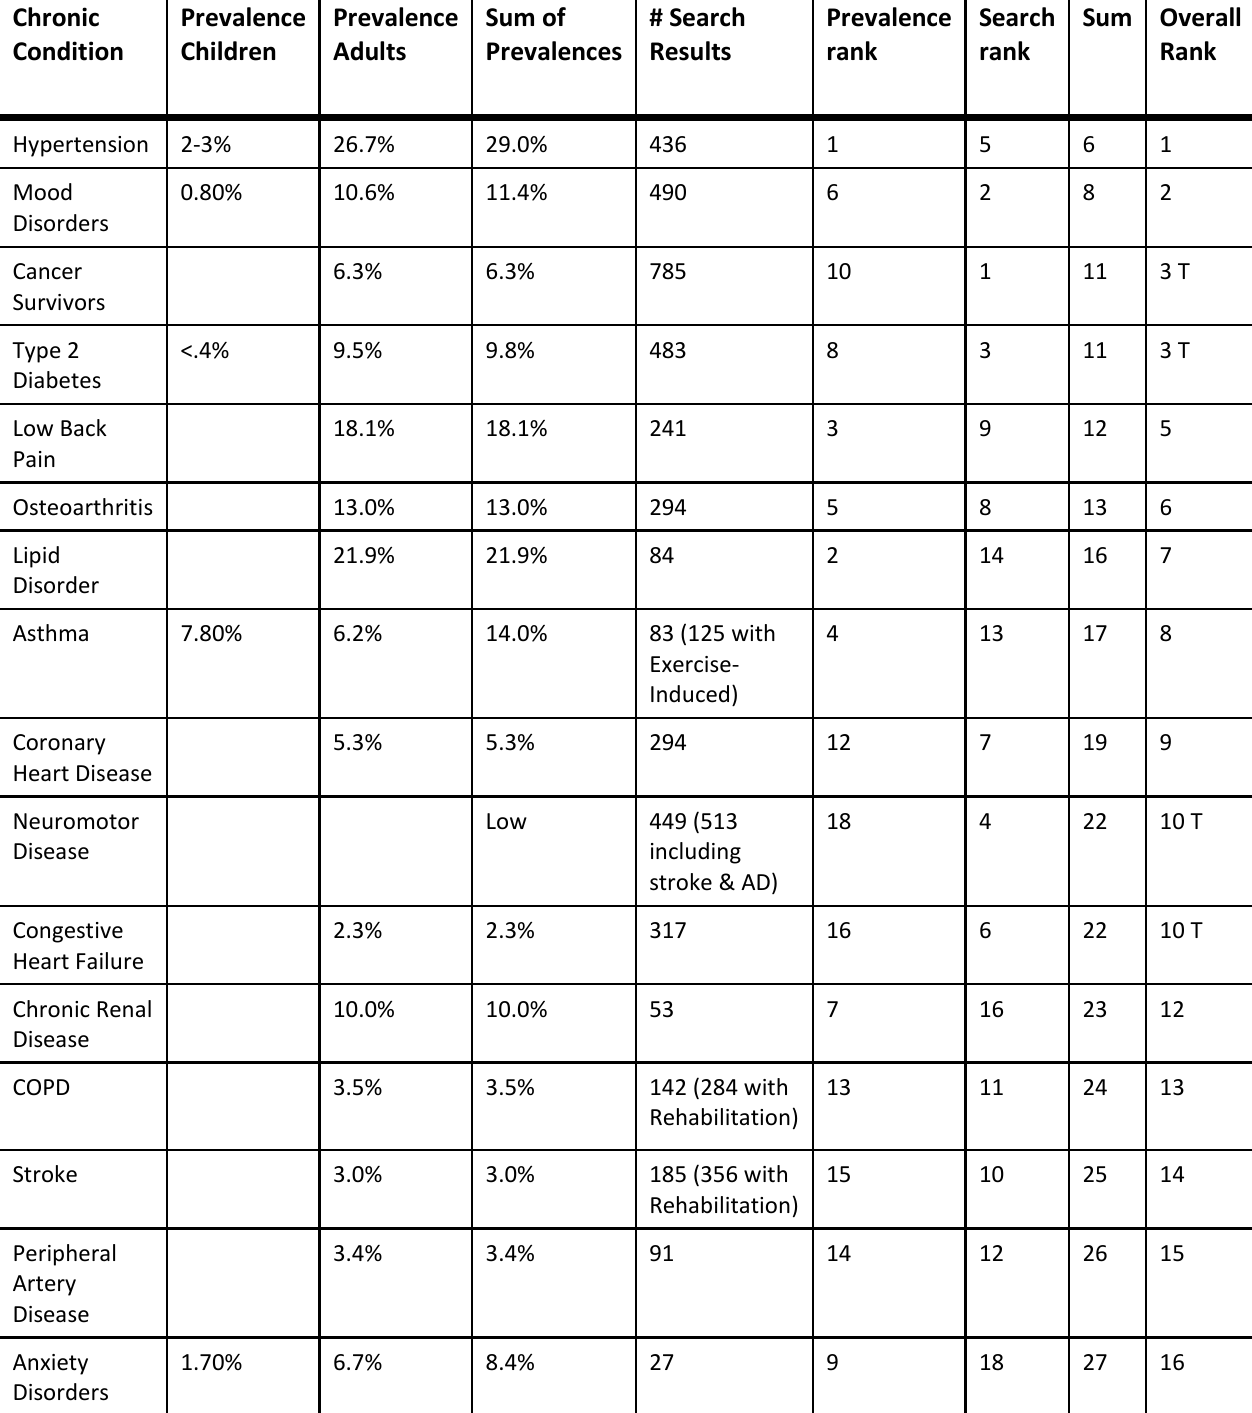
Table F10-1. Ranking of Chronic Conditions Based on Prevalence and Size of Published Literature Chronic Condition